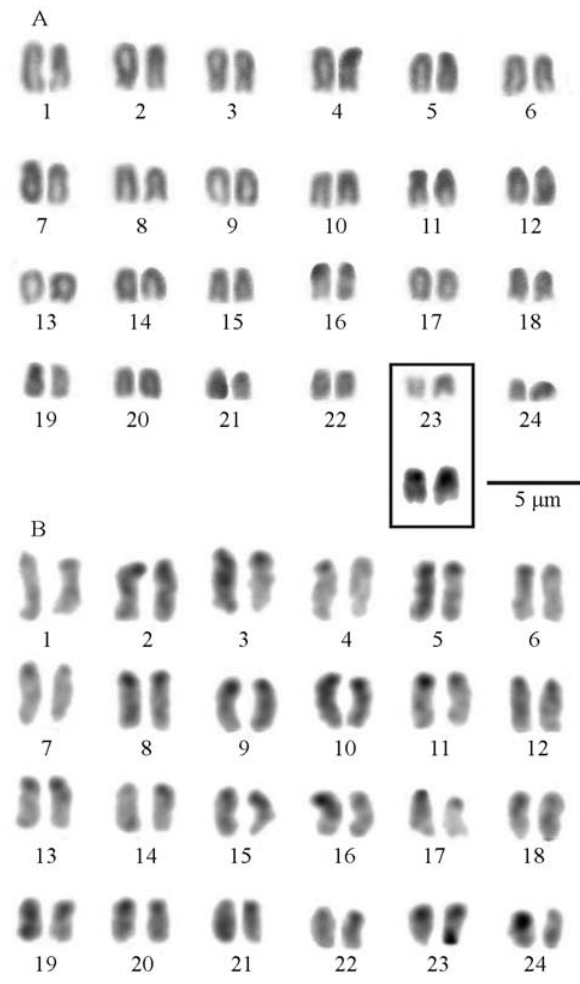
Figure 4 - Karyotype of Lutjanus cyanopterus . (A) Conventional Giemsa staining. In detail, the secondary constrictions equivalent to NORs. (B) C-banding in Lutjanus cyanopterus .